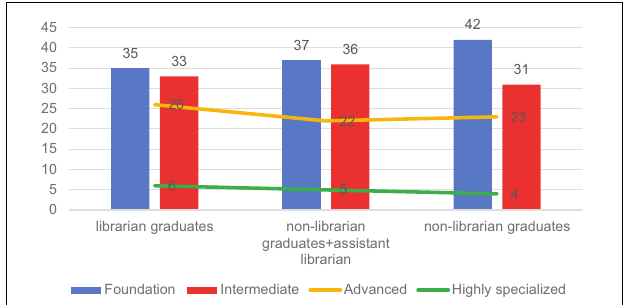
FIGURE 8 | Problem solving. Diplomas and qualifications.